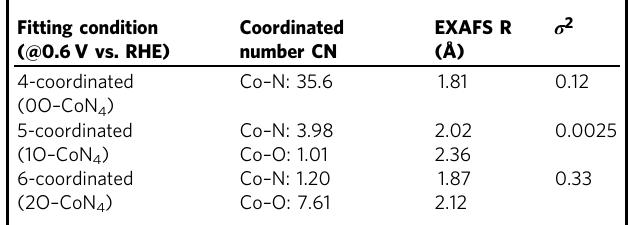
Table 1 E 0 edge from XANES and EXAFS fi tting parameters for sample under different conditions: as-prepared, under precatalytic (1.2 V), and catalytic state (1.0 – 0.4 V).